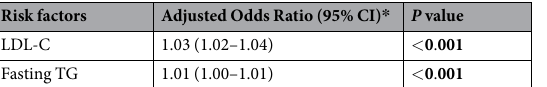
Table 3. Risk Factors for Asymptomatic Meibomian Gland Dysfunction by using Multivariate Logistic Regression. CI = confidence interval; MGD = meibomian gland dysfunction. Variables enrolled in this analysis include sex, age, waist circumference, body mass index, systolic blood pressure, diastolic blood pressure, fasting glucose, postprandial glucose, fasting triglyceride (Fasting TG), high-density lipoprotein cholesterol, low- density lipoprotein cholesterol (LDL-C), uric acid, high-sensitivity C-reactive protein, presence of metabolic syndrome, and presence of hepatic steatosis. * Adjusted for age and gender. Correlations significant at P < 0.05 are bolded.